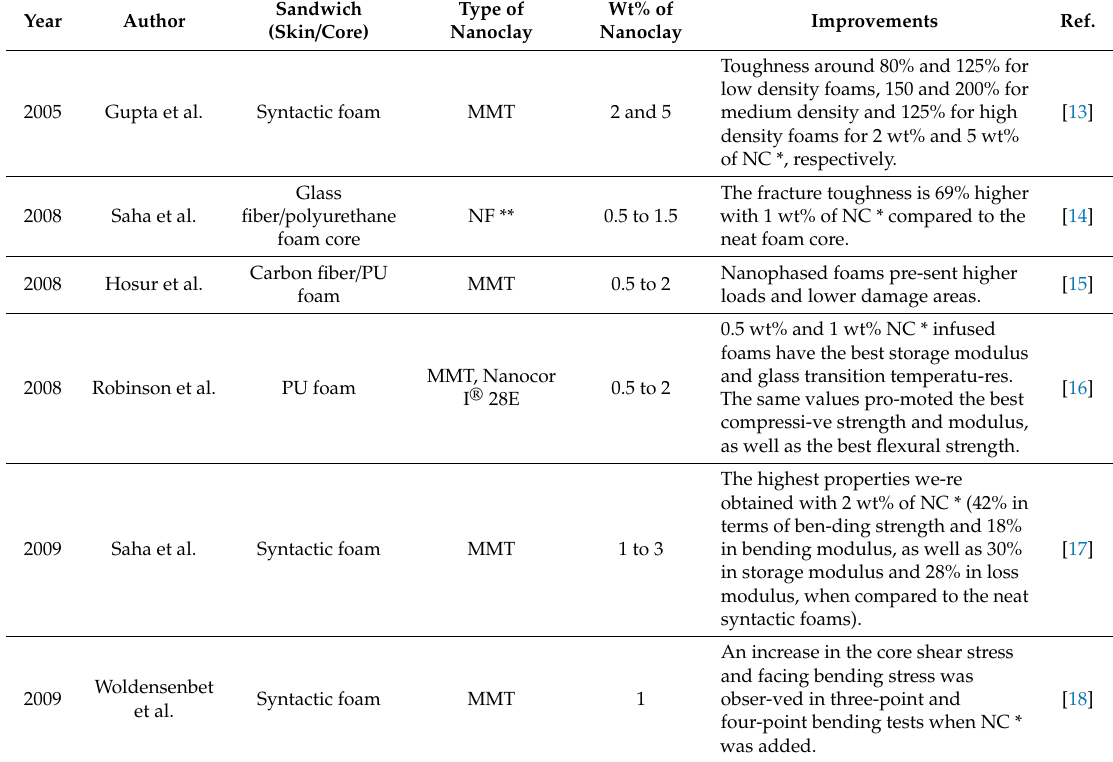
Table 1. Summary of the benefits obtained with nanoclays added to the